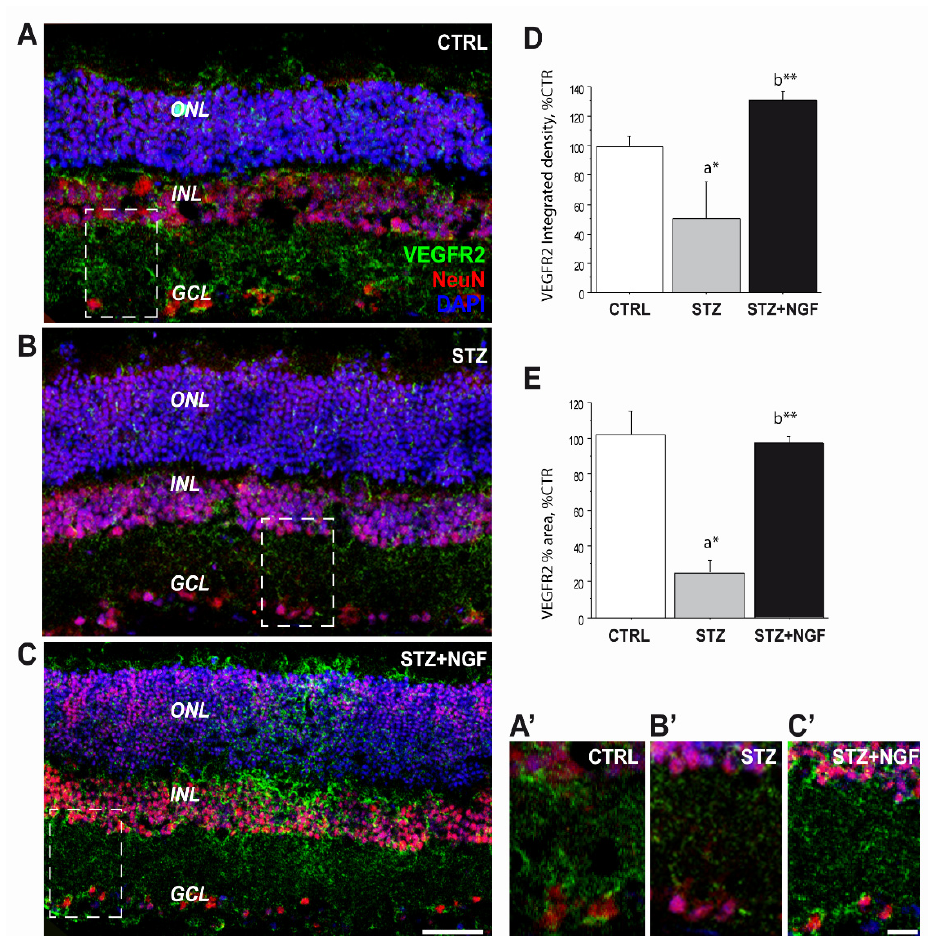
Figure 5. ( A – E ). VEGFR2 expression was severely affected upon STZ injection and recovered after ed-NGF treatment. ( A – C ) Representative VEGFR2 (green)/NeuN (red) double immunofluorescent staining of the retina from healthy and diabetic rat retina, with or without topical NGF administration. ( A’ – C’ ) The high magnification of the VEGFR2/NeuN staining in the islets showing reduced VEGFR2 expression in the GCL layer of STZ retina, and its recovery after ed-NGF. ( E – D ). Quantification of the VEGFR2 immunofluorescence in the retina. The total integrated density ( D ) and percentage of area covered by VEGFR2 staining ( E ) in the three retinal layers. The results are expressed as mean ± SEM. Scale bar: 50 µ m; islet: 30 µ m. Statistical significance is indicated with * p < 0.05, ** p < 0.01. “a” vs. CTRL group; “b” vs. STZ group. CTRL, healthy rats; STZ, streptozotocin; STZ+NGF, streptozotocin+nerve growth factor eye